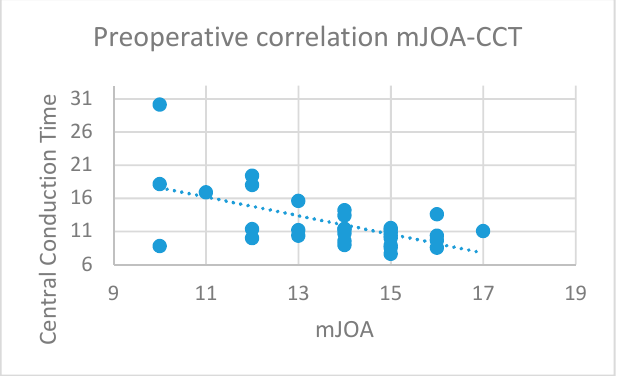
Figure 4. Preoperative abnormal values of motor evoked potentials (MEPs) were related to worse mJOA scores: This inverse correlation was statistically significant (r = − 0.59, p = 0.0004). We found no correlation between abnormal preoperative SSEPs and preoperative mJOA